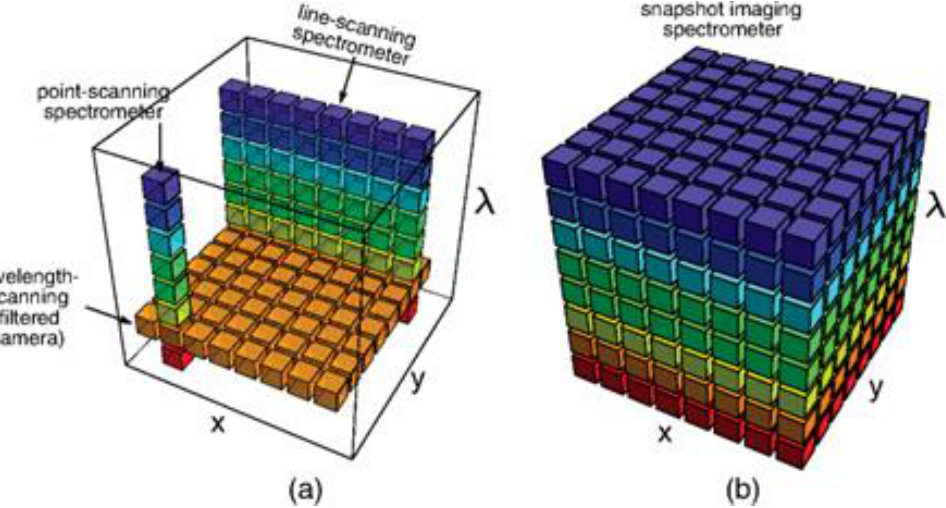
Figure 1. Schematic of the way data cubes are acquired by different spectral imaging techniques. ( a ) Spectral scanning imaging. ( b ) Snapshot spectral imaging.